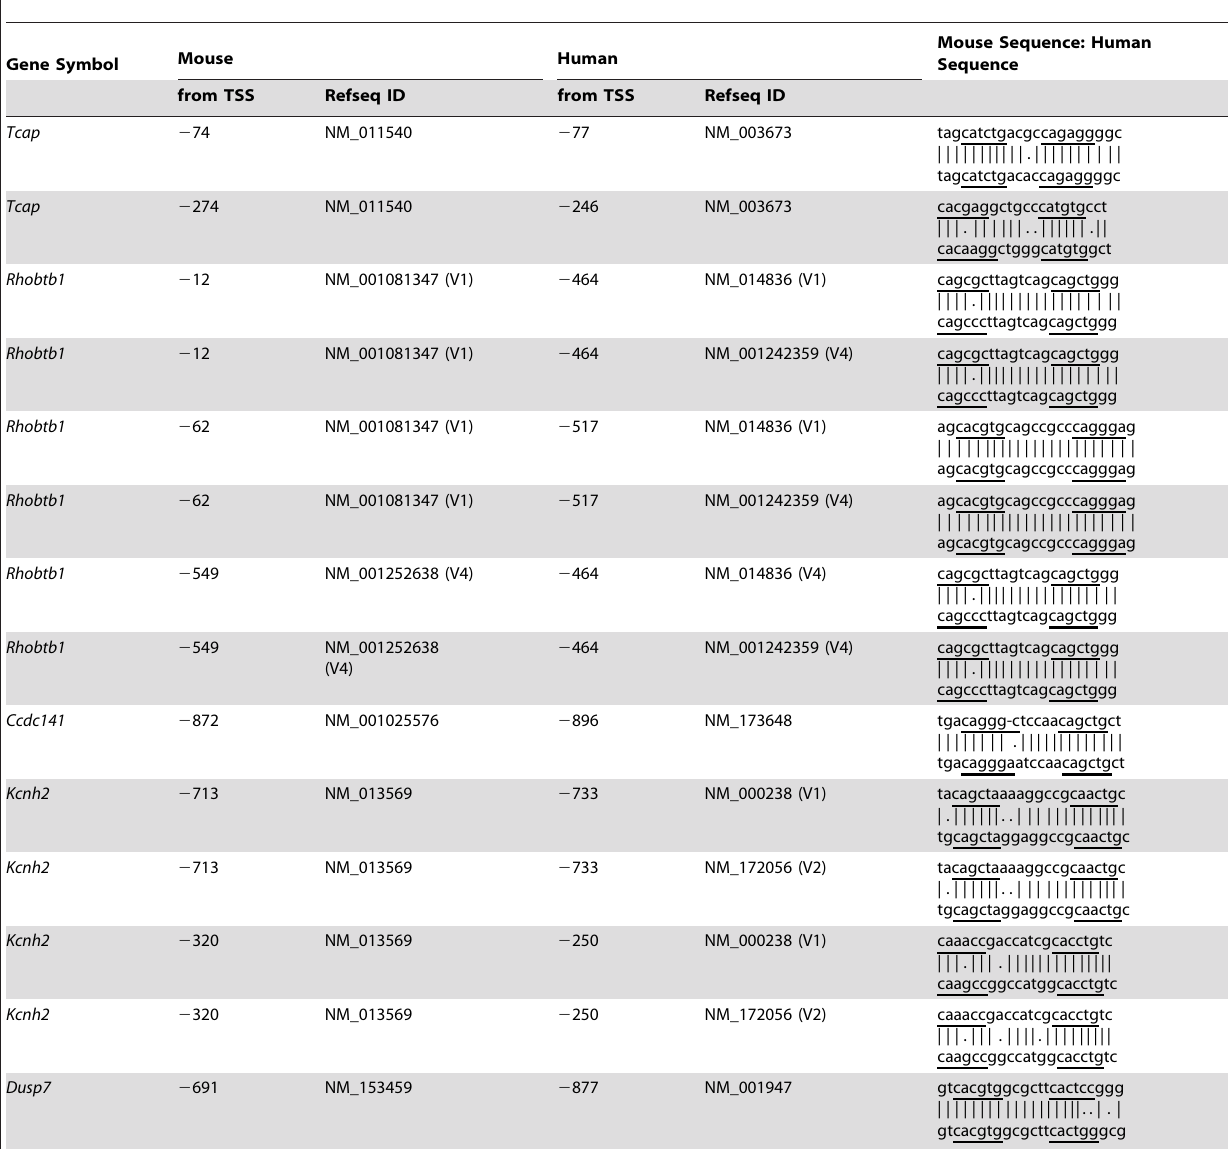
Table 3. Heart-enriched rhythmic proteins with human-mouse conserved E-box motifs.